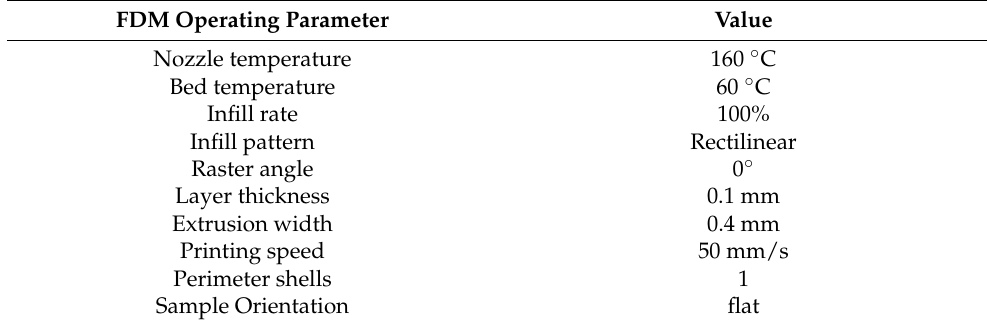
Table 1. FDM process